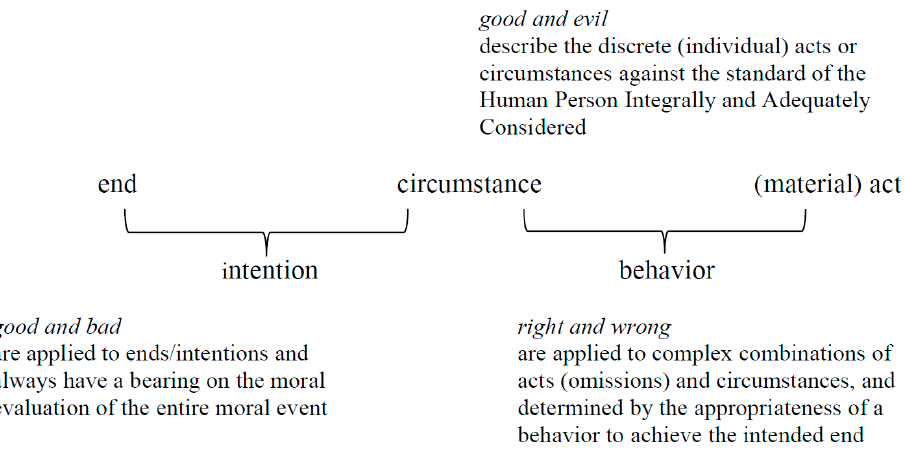
Figure 2. The moral event.